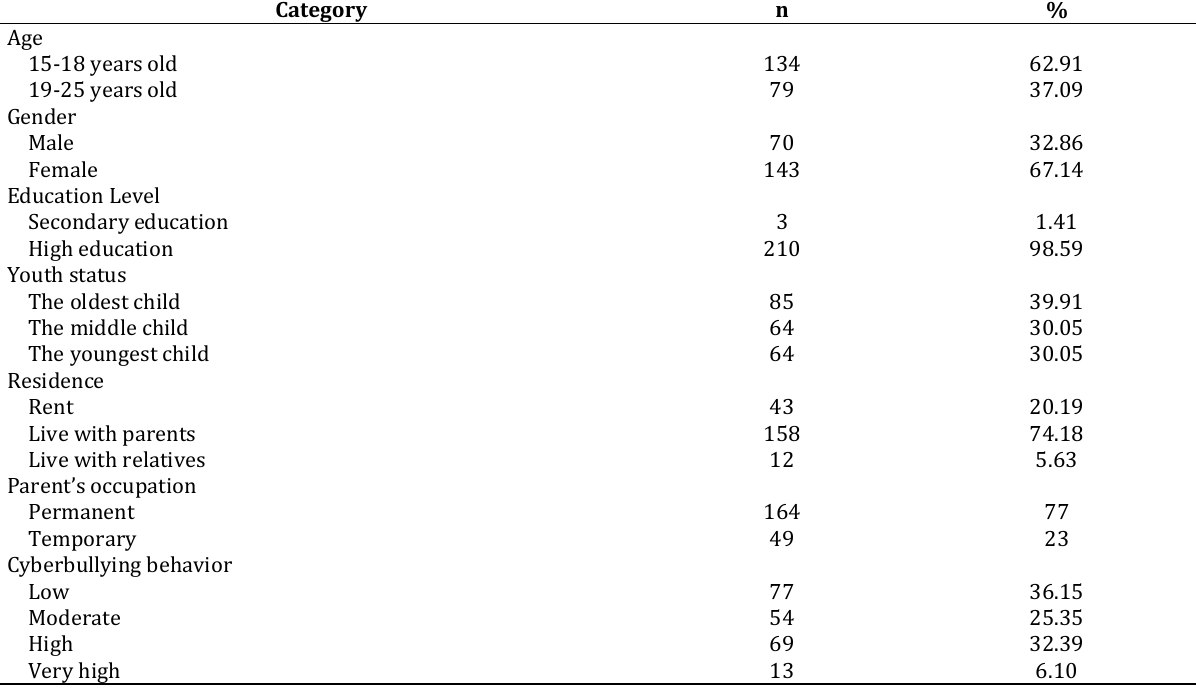
Table 1. Characteristic Respondents (n=213)